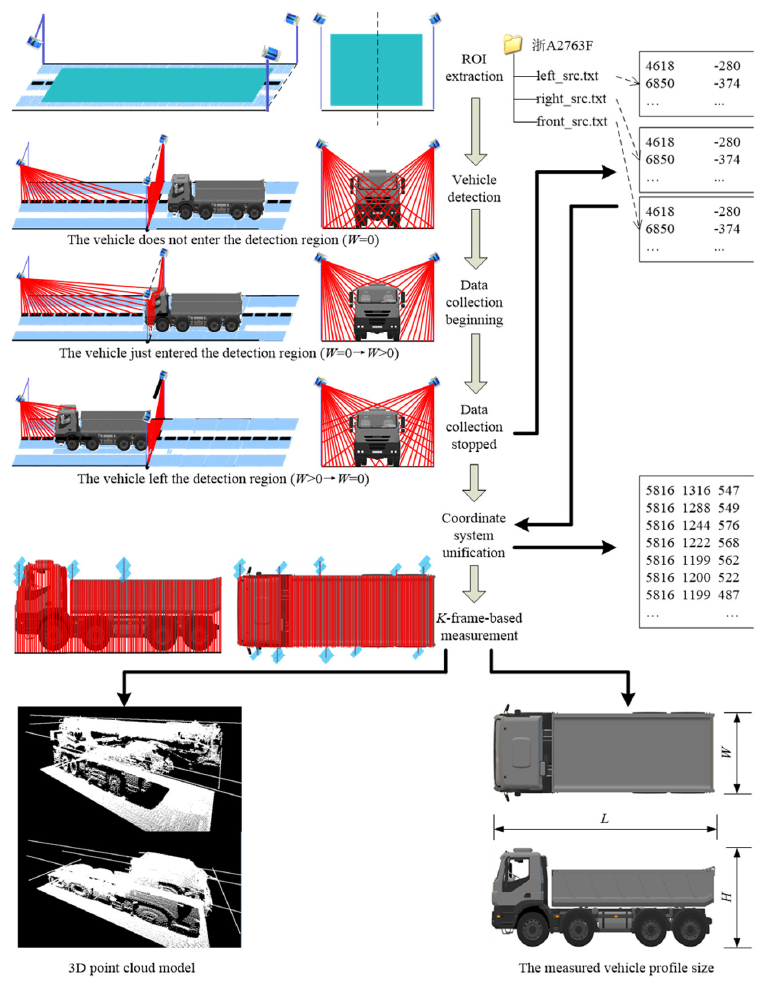
Figure 2. The workflow chart of the measurement process.